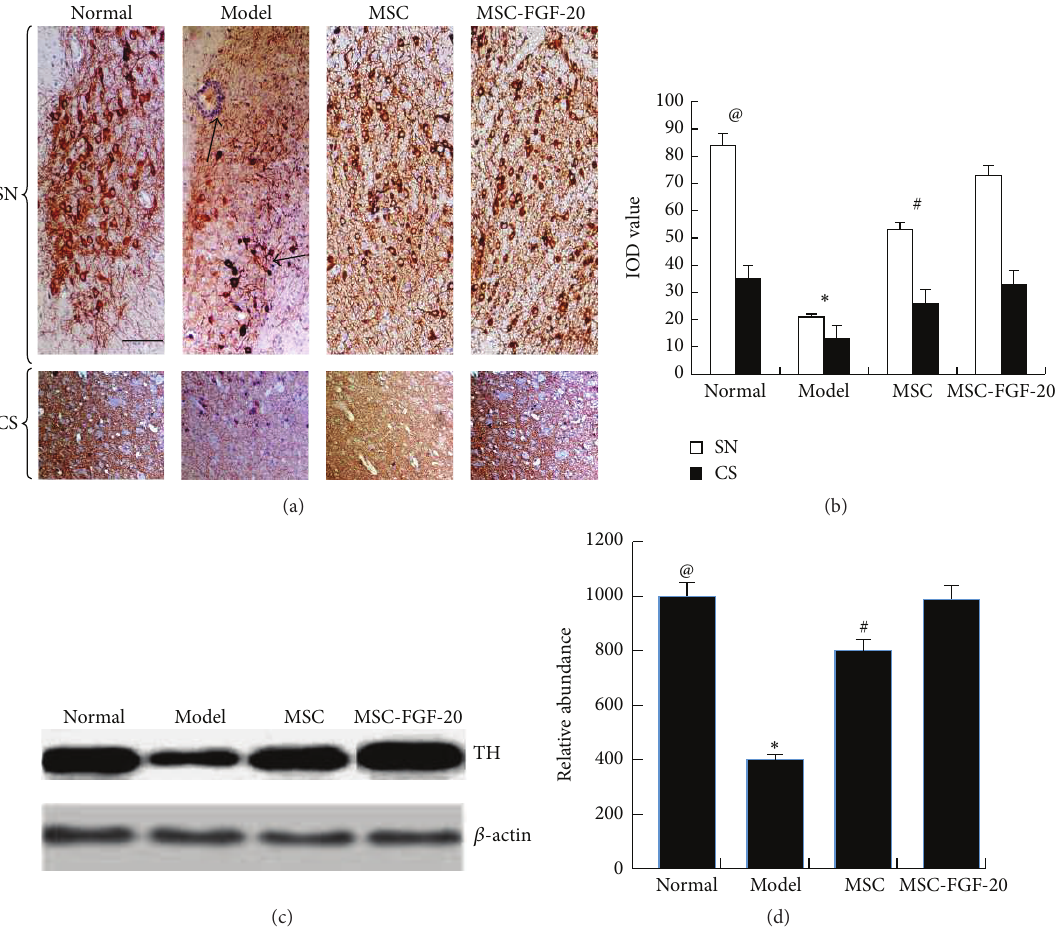
Figure 3: TH expressions in PD mice after cell treatment. (a, b) TH immunohistochemistry staining results showed that the number of TH- positive cells greatly decreased in the model group (scale bar = 50 𝜇 m), and the cells were not neatly arranged, axons and dendrites became thinner and broken , anastomosing networks of axons became loose, and infiltration of tangled glial cells was seen (arrows). After hUC-MSC and hUC-MSC-FGF-20 treatment, TH-positive cells stained darker and the number of the cells was obviously increased. (c, d) WB results showed that tendency of TH expression changes in the corpus striatum was consistent with immunohistochemistry results ( @ 𝑝 < 0.01 , the normal group versus the model group; ∗ 𝑝 < 0.01 , the model group versus MSC and MSC-FGF-20 group; # 𝑝 < 0.05 , MSC group versus MSC-FGF-20